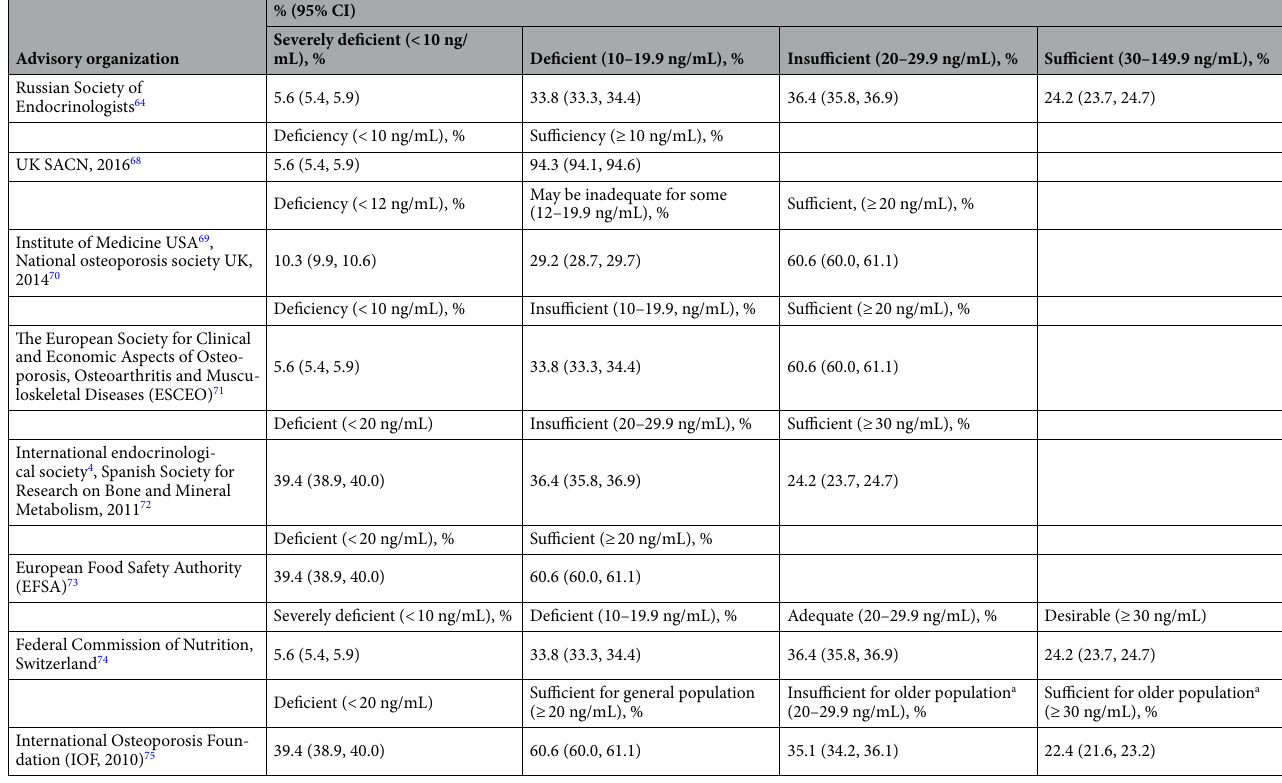
Table 3. Proportion of the population meeting specific thresholds regarding serum 25(OH)D status from selected professional advisory organizations. Data are from 2013 to 2018 and are from all months of the year. a Defined as < 60 years by the International Osteoporosis Foundation. Because the IOF thresholds are age- specific, this is the only group where the column percentages will not add to